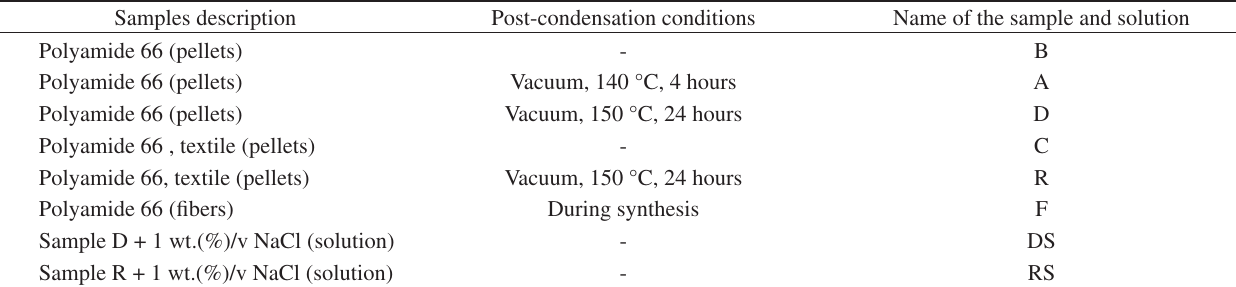
Table 1. Nomenclature of the polyamide 66